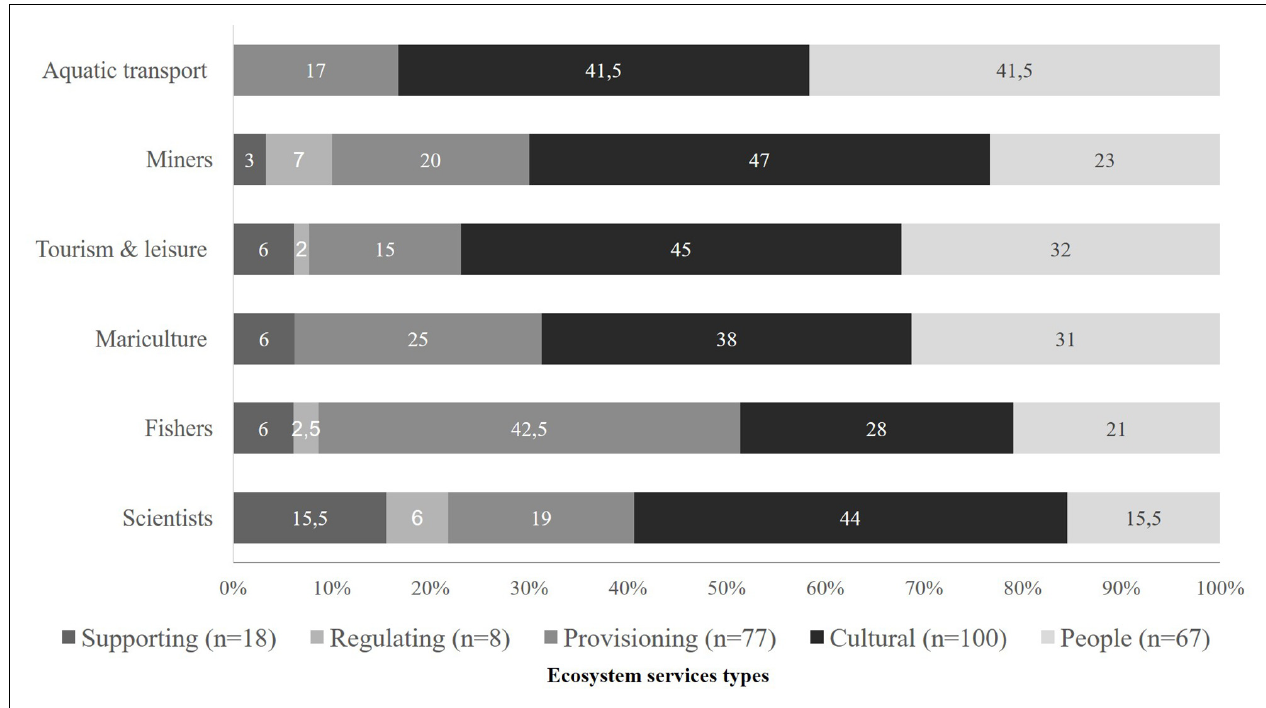
FIGURE 3 | Relative frequency of distribution in classifications of ES types based on the perception of six direct user groups of Babitonga Bay ( N = 270 citations), identified in 19 workshops. Numbers given in legends refer to the absolute frequency of classifications per type of ecosystem